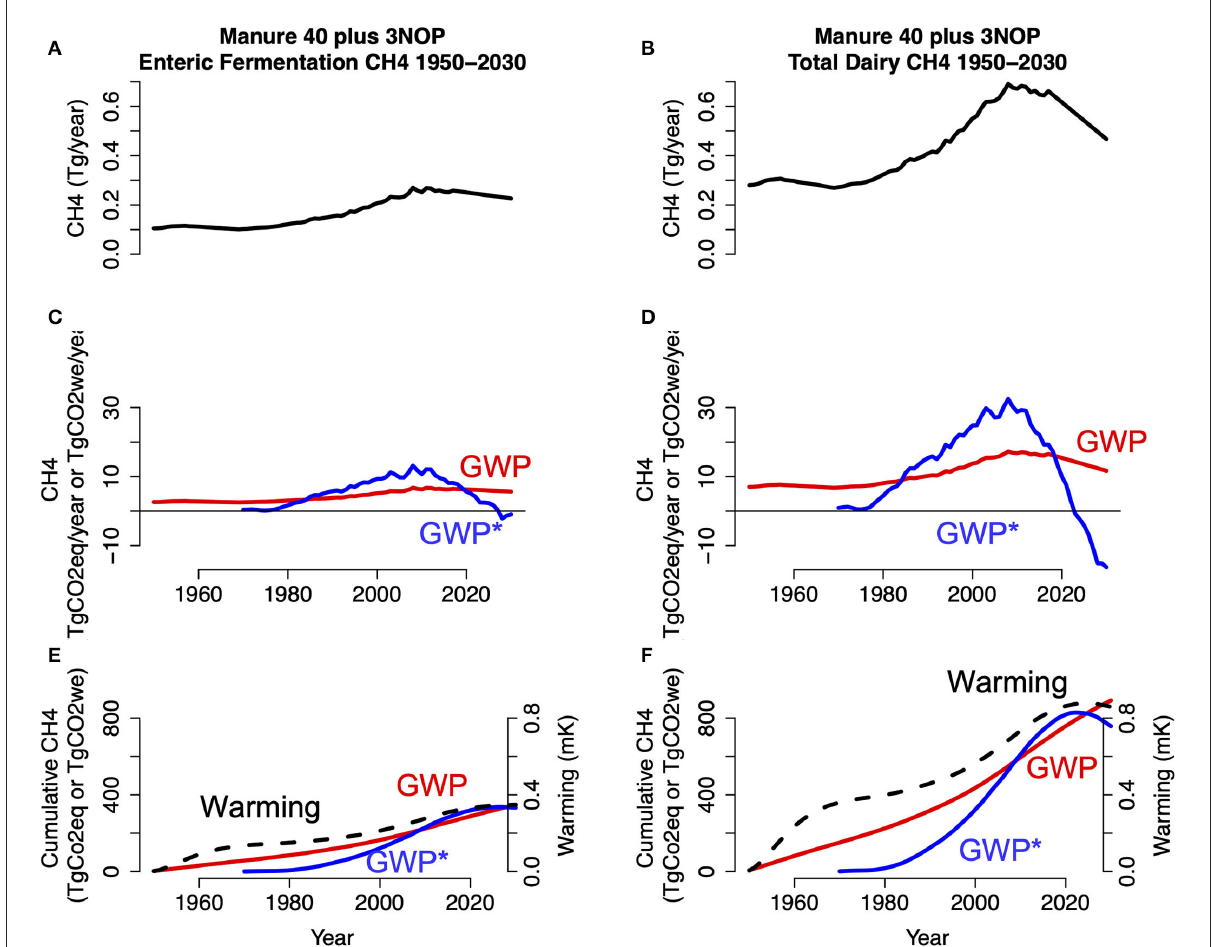
FIGURE5 California future enteric fermentation and total “Manure 40 plus 3NOP” reduction scenario CH 4 emissions, comparison of these emissions converted to CO 2 eq and CO 2 we using GWP and GWP*, respectively, and cumulative CO 2 eq and CO 2 we with emissions-forced warming. The x -axis represents years, and the y -axis represents annual CH 4 emissions (A, B) , annual CO 2 eq or CO 2 we (C, D) , or cumulative CO 2 eq or CO 2 we (E, F) . Enteric fermentation estimates are given by (A, C, E) , and total dairy emissions are given by (B, D, F) . CO 2 we are represented in (C–F) by the blue solid line (“GWP*), CO 2 eq are represented in (C–F) by the red solid line (“GWP”), and temperature is given in (E, F) by the dashed black line (“Warming”). The temperature axis (C) is scaled by 0.001 mK/TgCO 2 , or 1 K/TtCO 2 , as in previous figures. The horizontal black line in (C, D) is at y =